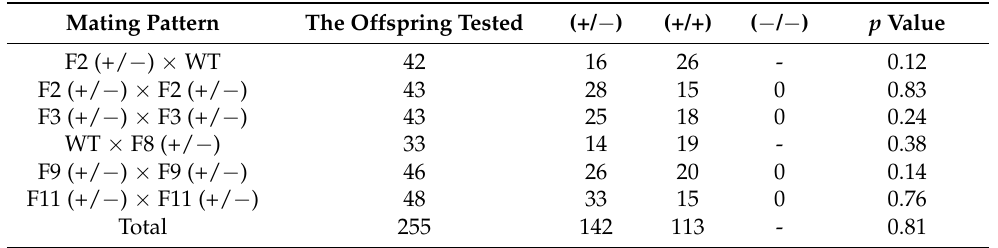
Table 3. The genotypes of the offspring with mutated prmt5 . Mating